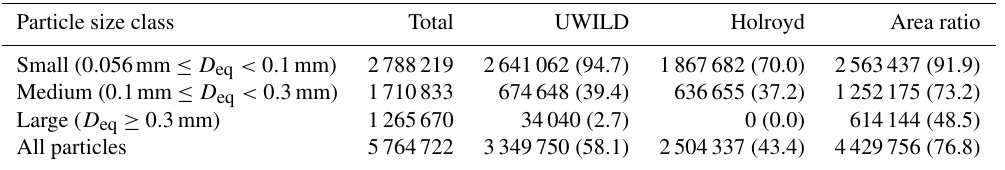
Figure 7. F 1 scores are shown for UWILD (green), Holroyd (red), and area ratio (blue) for different size classes. F 1 scores for small and medium particles may be slightly underestimated due to the presence of liquid drops in the ice-dominated TTV set. Table 3. Total particles and number of particles classified as liquid from the three-phase discrimination algorithms for each size class. Numbers in parentheses are the percentage of total particles classified as liquid. SOCRATES flights RF01–RF14 are